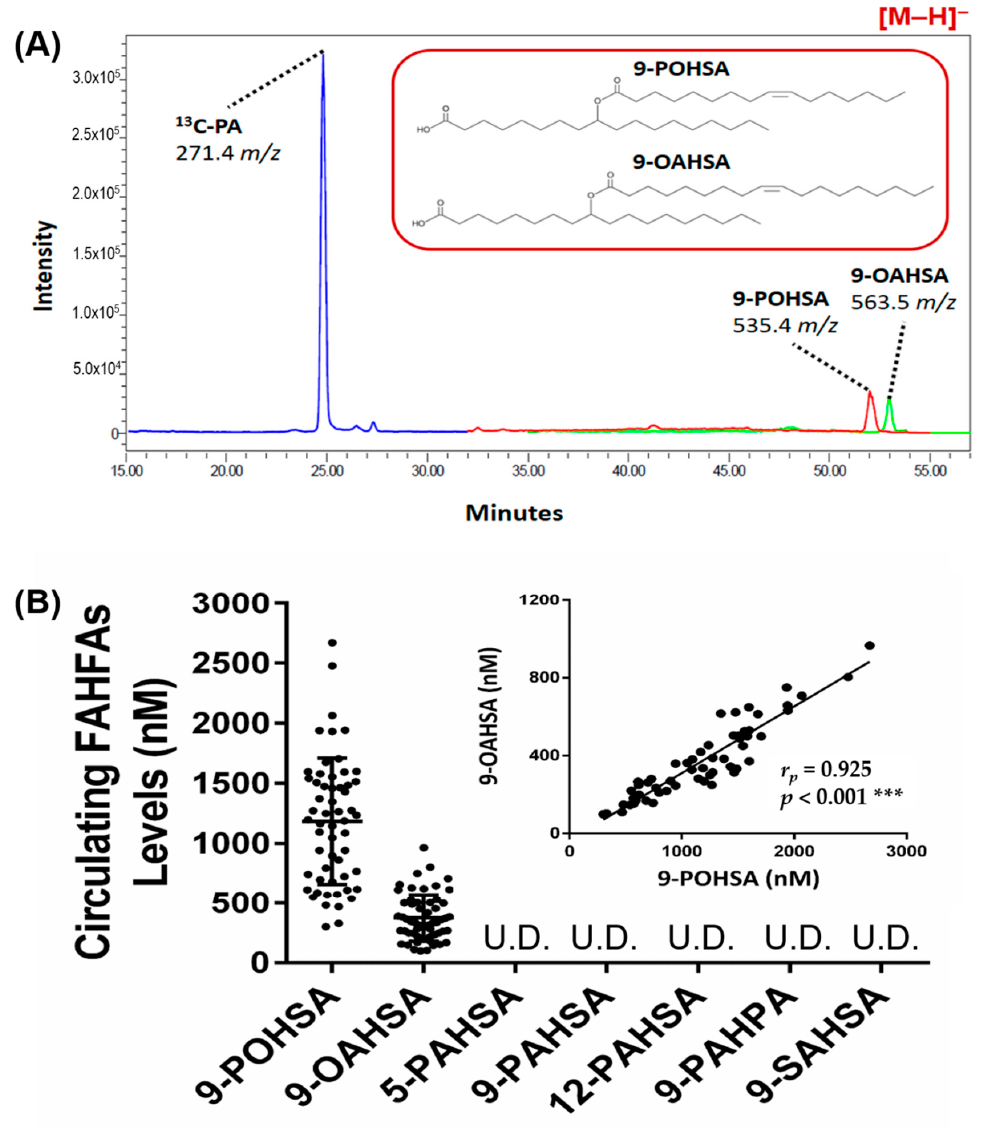
Figure 3. 9-POHSA and 9-OAHSA were major endogenous FAHFAs in healthy subjects. Both 9-POHSA and 9-OAHSA were clearly measured in healthy subjects, where 10 µ M 13 C-palmitic acid (PA) was used as an internal standard ( A ). 9-POHSA and 9-OAHSA were major endogenous FAHFAs and had a strong positive correlation with each other ( r = 0.9254, p < 0.001) while the other five types of FAHFAs (5-PAHSA, 9-PAHSA, 12-PAHSA, 9-PAHPA, and 9-SAHSA) were below the limit of detection or undetected ( B ). r p : Pearson correlation coe ffi cient. Data are presented as mean ± SD, U.D. = undetected (*** p < 0.001).